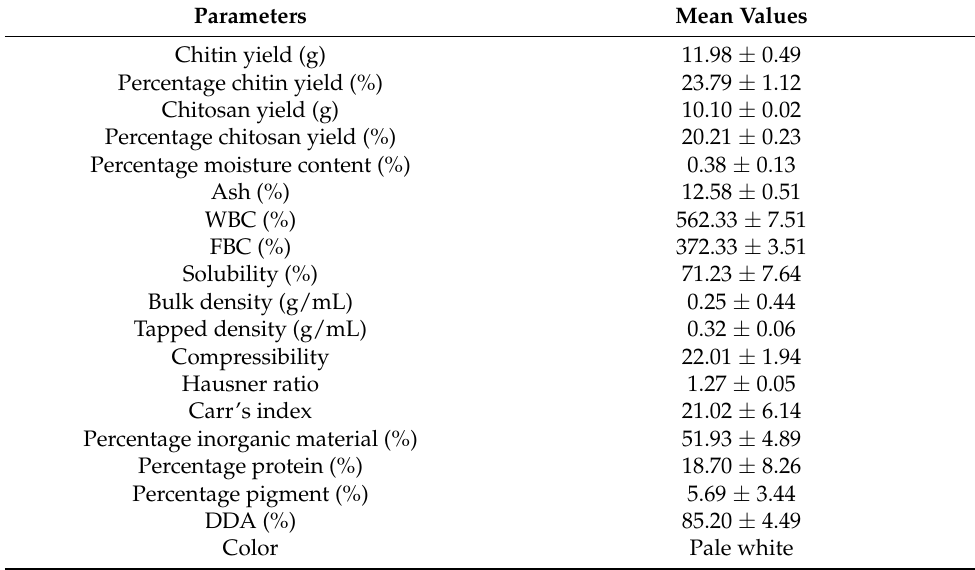
Table 4. Physicochemical parameters of